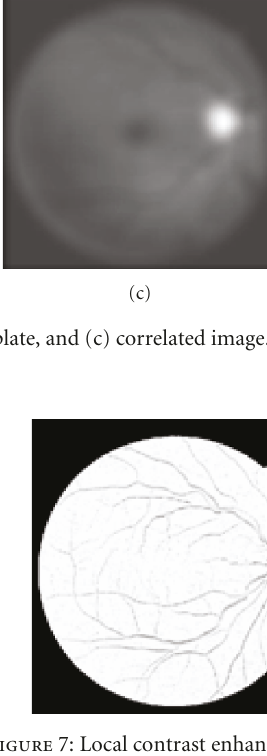
Figure 6: OD removing results: (a) original image, (b) reducing of OD e ff ect in the original image.